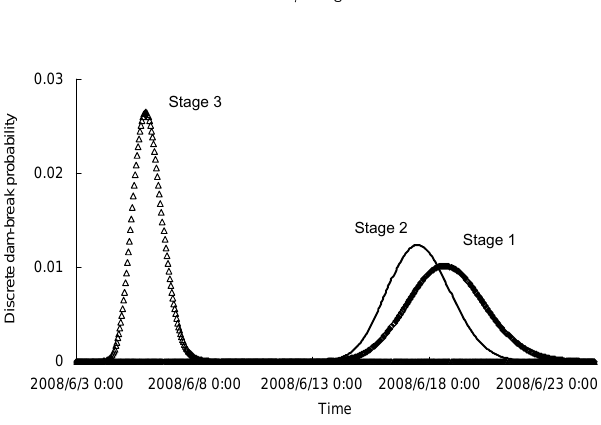
Fig. 8. Discrete probability of dam failure in three stages with a time interval of one hour